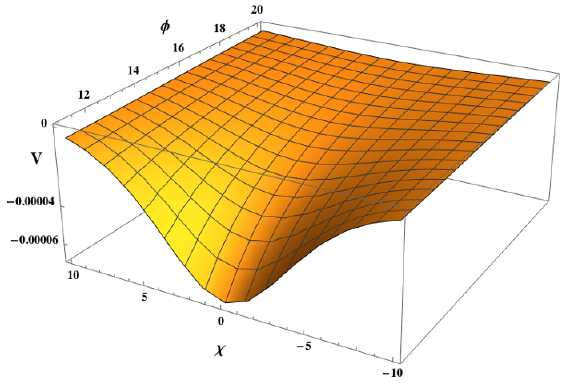
Figure 1 . The potential energy V plotted over a region of (cid:30) - (cid:31)